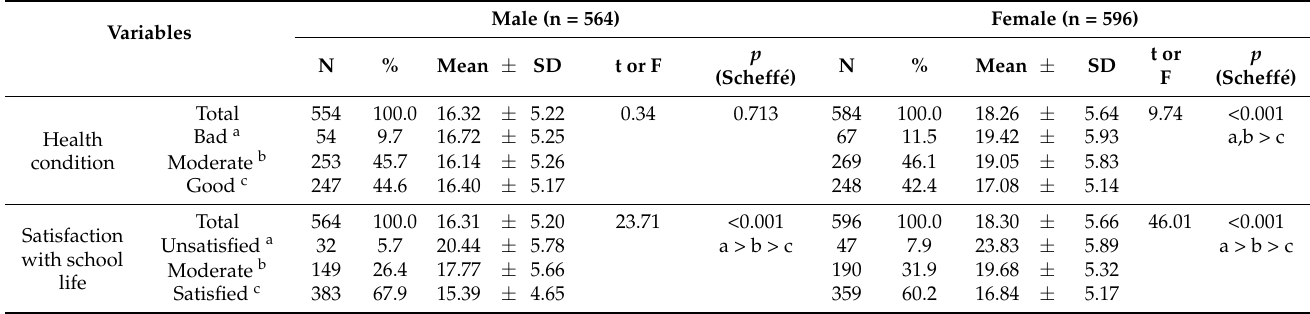
Table 2. Gender differences in depression according to multicultural adolescents’ health condition and school life satisfaction (n = 1160).